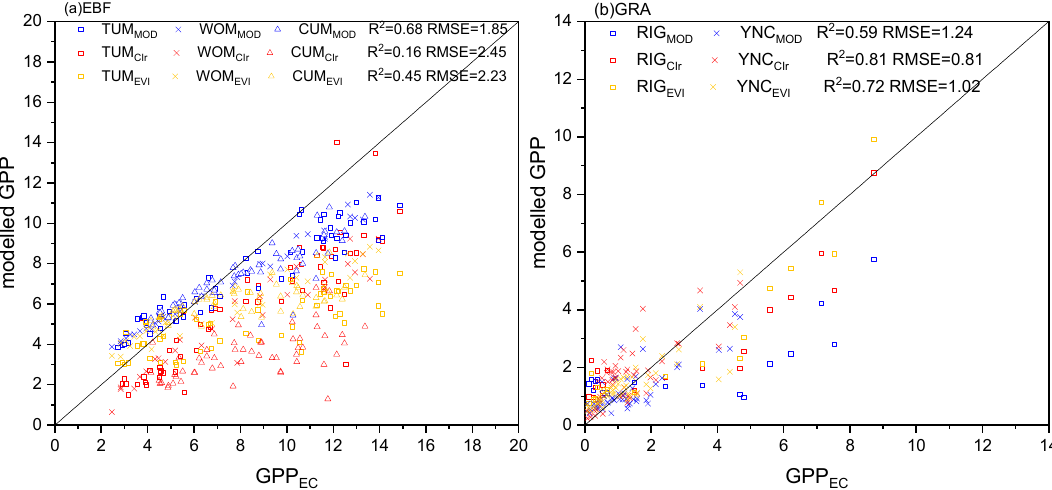
Figure 11. Cross-site comparison of GPP EC and GPP modeling results, including MOD17A2H product (presented as Sitename MOD ), GPP EVI (presented as Sitename EVI ), and GPP CIr (presented as Sitename CIr ). The GPP EVI and GPP CIr across selected EBF sites were estimated by 1.93 × EVI × PAR + 2.45 and 0.32 × CIr × PAR + 2.56, respectively. The GPP EVI and GPP CIr across selected grassland sites were estimated by 1.33 × EVI × PAR − 0.5 and 0.31 × CIr × PAR + 0.05, respectively. The units of GPP EC , modeled GPP, and RMSE are gC · m − 2 · day − 1 . The black line in the middle is the 1:1 line.